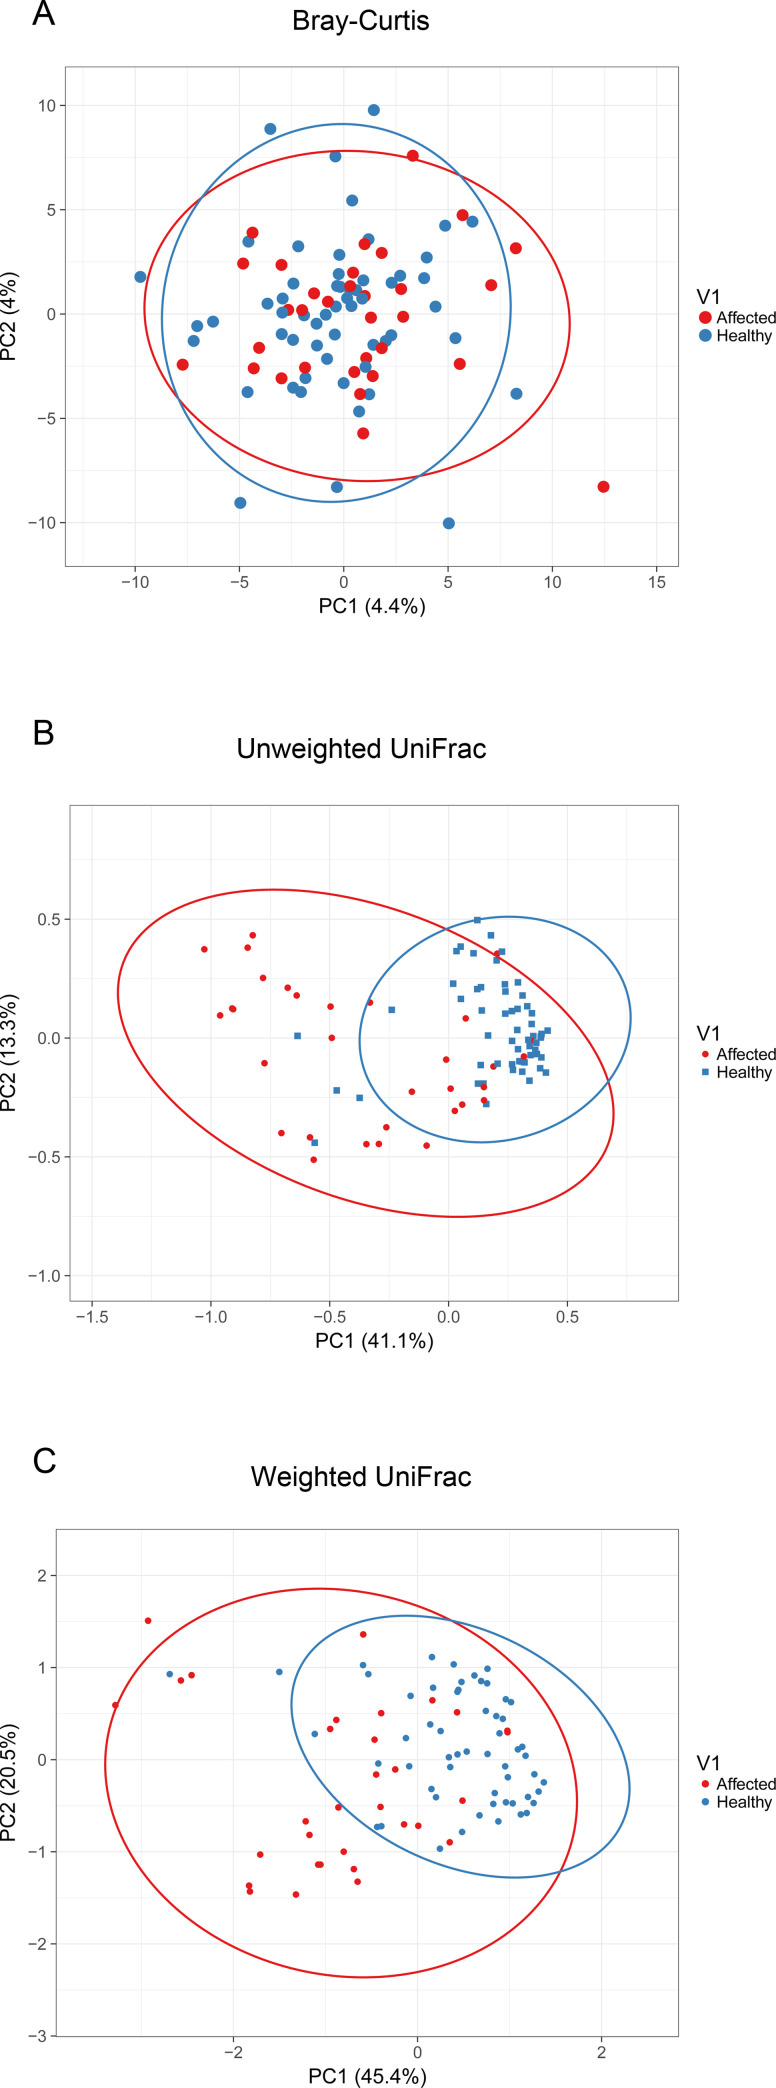
Beta diversity principal coordinates analysis between healthy and affected dogs.PCoA analysis based on Bray Curtis (A), Unweighted (B) and Weighted UniFrac (C) distance matrix between healthy and affected dogs.